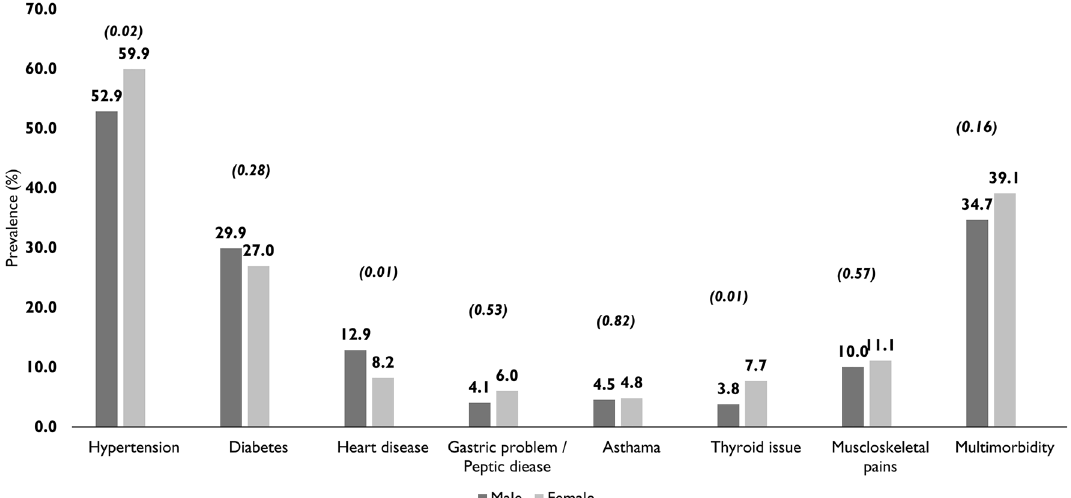
Figure 1. Prevalence of non-communicable diseases and multimorbidity stratified by gender (n = 1182); Statistical significance is shown in parenthesis (Chi squared